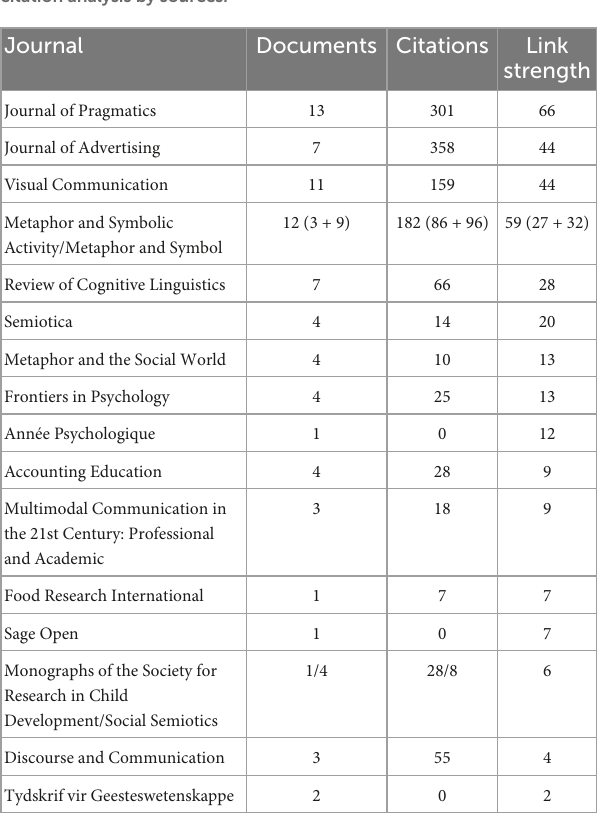
TABLE 2 Journal(s), citation and link strength in the 17 clusters from citation analysis by